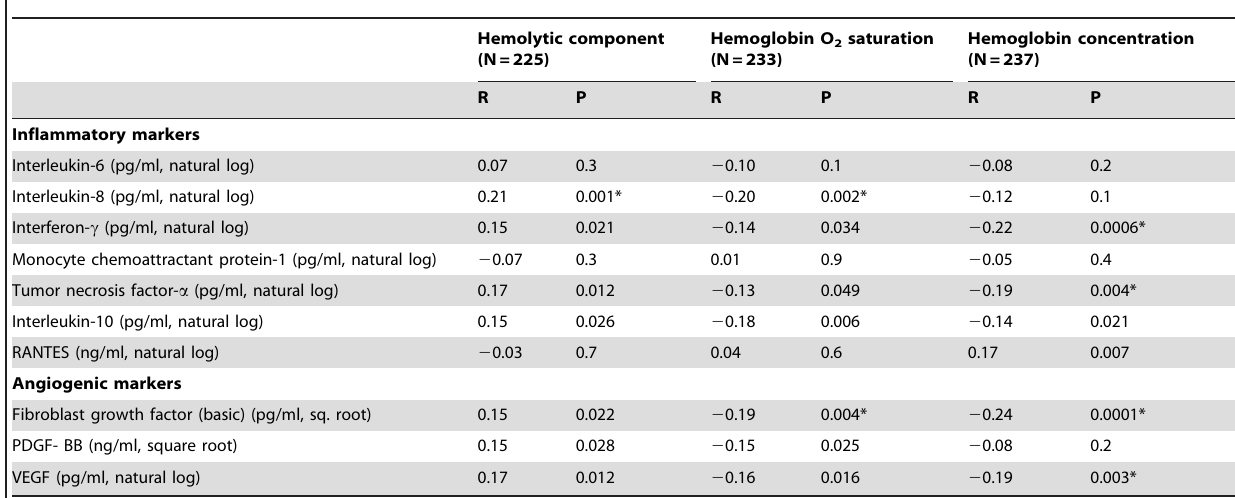
Table 2. Bivariate relationships of biologic markers with hemolytic component and hemoglobin oxygen saturation in patients with sickle cell disease [Pearson correlation].